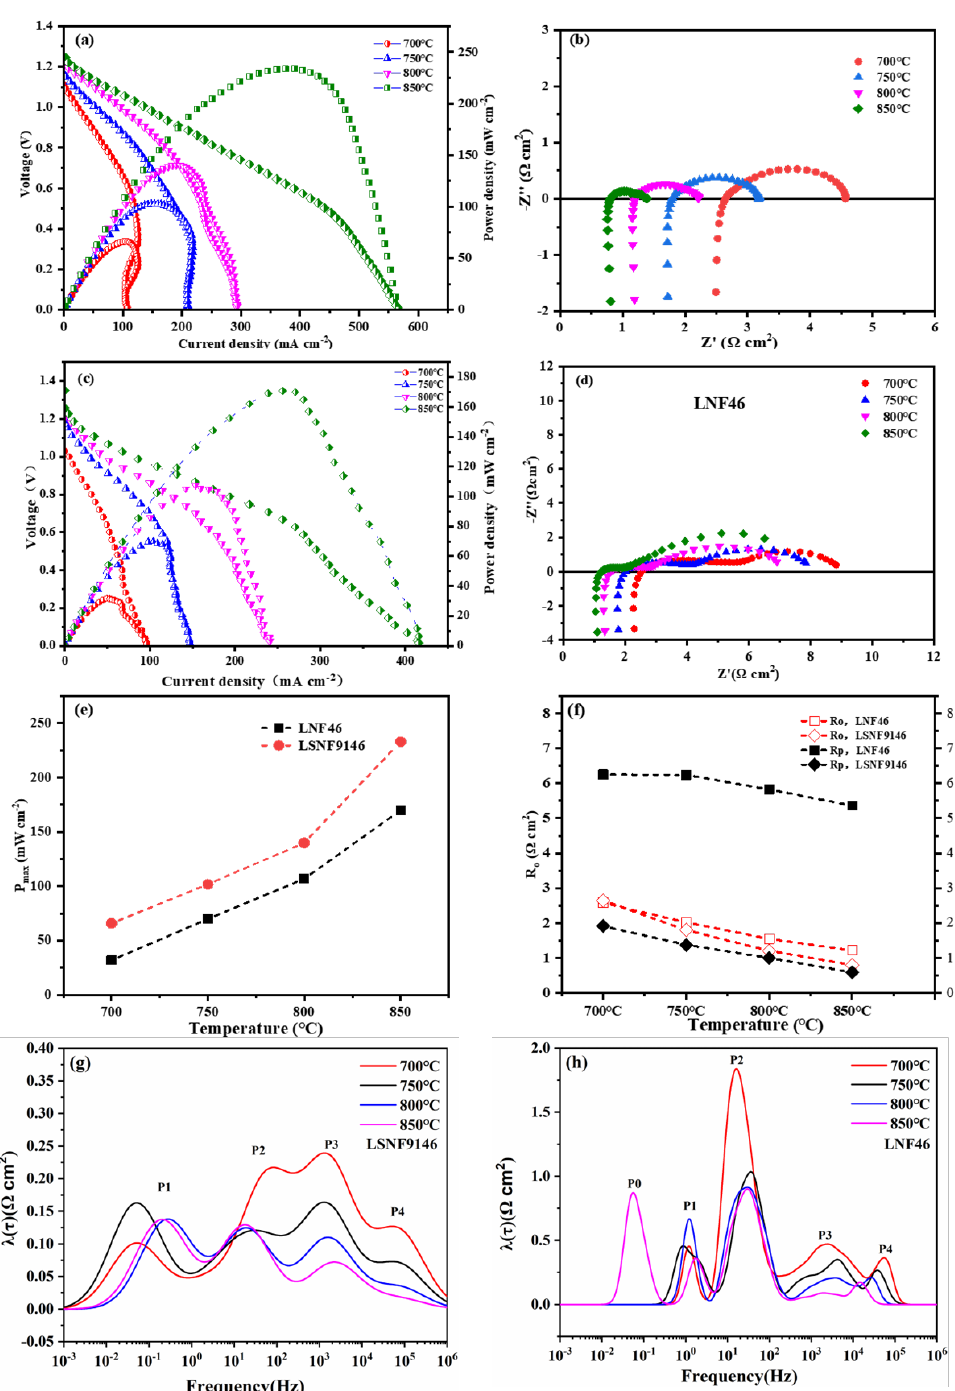
Figure 6. Electrochemical characteristics of symmetrical fuel cells operated in humidified methane fuels at 30 mL min −1 and ambient air oxidants over the temperature range of 700-850 °C: ( a ) IVP curves with LSNF9146 electrode and ( b ) corresponding EIS at open circuits; ( c ) IVP curves with LNF46 electrode and ( d ) corresponding EIS at open circuits; ( e ) Comparison of peak power density (P max ) of symmetrical cells with LNF46 and LSNF9146 electrodes at 700-850 °C; ( f ) R o and R p of LNF46 and LSNF9146 under the same conditions; ( g ) DRT analysis results of SSOFC with LSNF9146 electrode at elevated temperatures; ( h ) DRT analysis results of SSOFC with LNF46 electrode. With reference to the R p result of cathode electrode in Figure 5, it can be seen that the anode R P (derived by subtracting the cathode contributions from the combined interfacial polarization resistances) dominates the main contribution on the total impedance at all